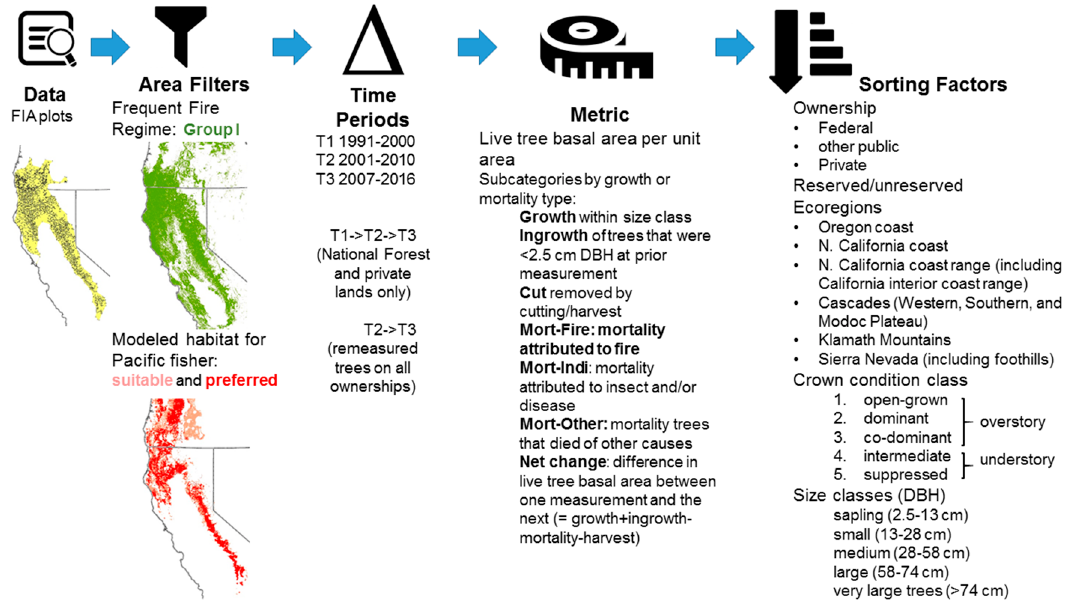
Figure 4. Schematic showing the factors considered in the trend analysis of large hardwoods.